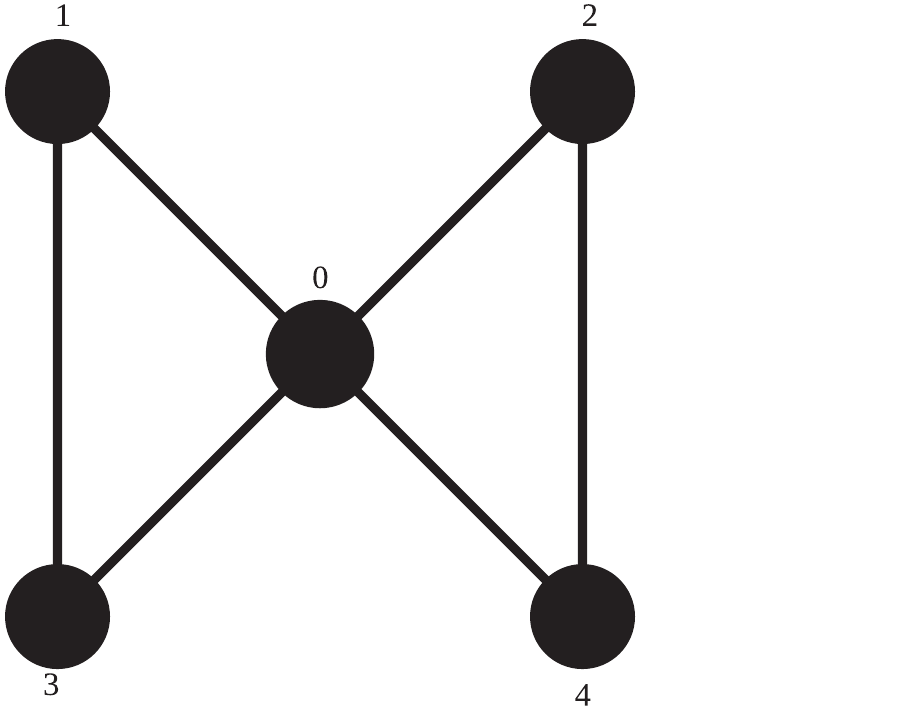
Fig 5. Graphlet 18 with numbered vertices. The graphlet has all edges in Eq (8).